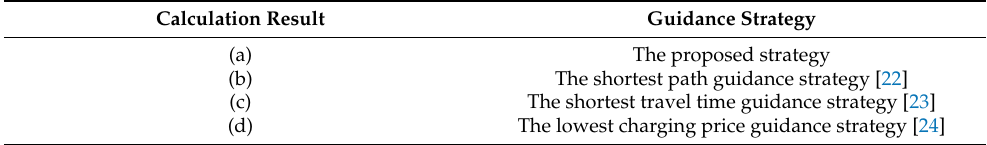
Table 5. Guidance Table 5. Guidance strategy.